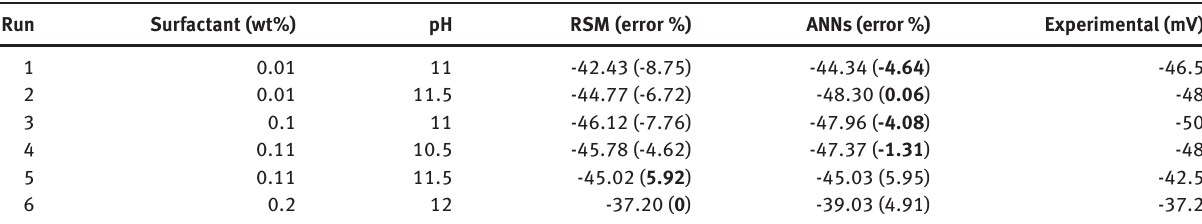
Values in bold represent lower error